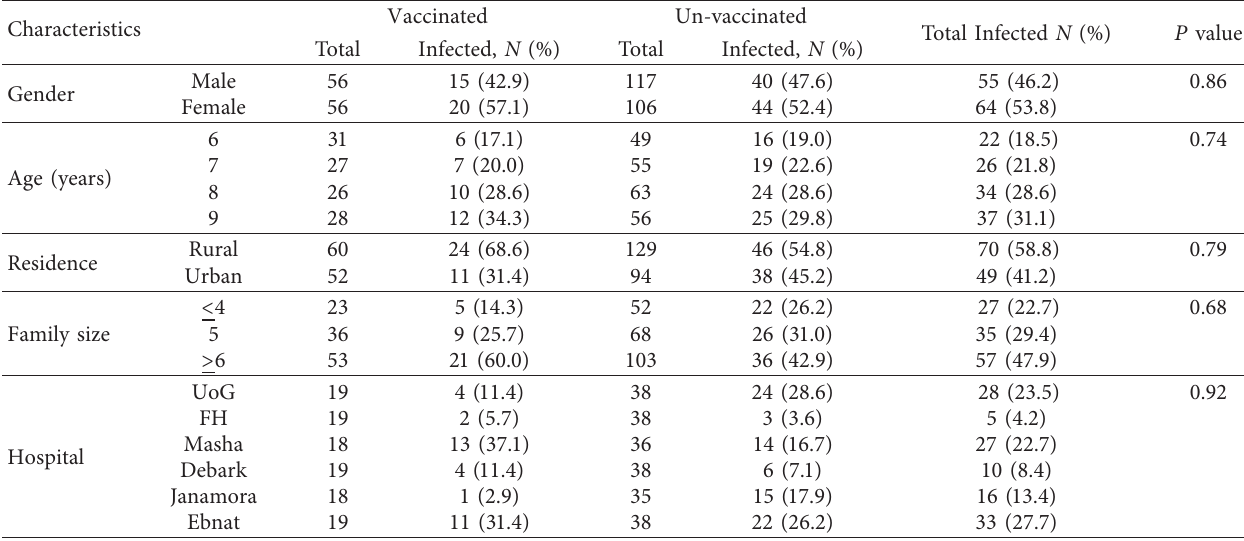
Table 3: Distribution of pertussis positives among vaccinated and un-vaccinated control groups in different hospitals and socio-de- mographic variables, Amhara Regional State, Ethiopia, 2019. Characteristics